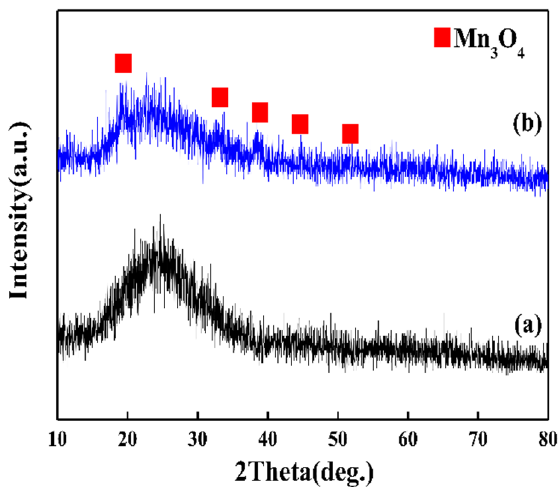
Figure 9. XRD patterns of ( a ) CN‐Mn1 and ( b ) CN‐Mn2 after the 100th CV cycles test.